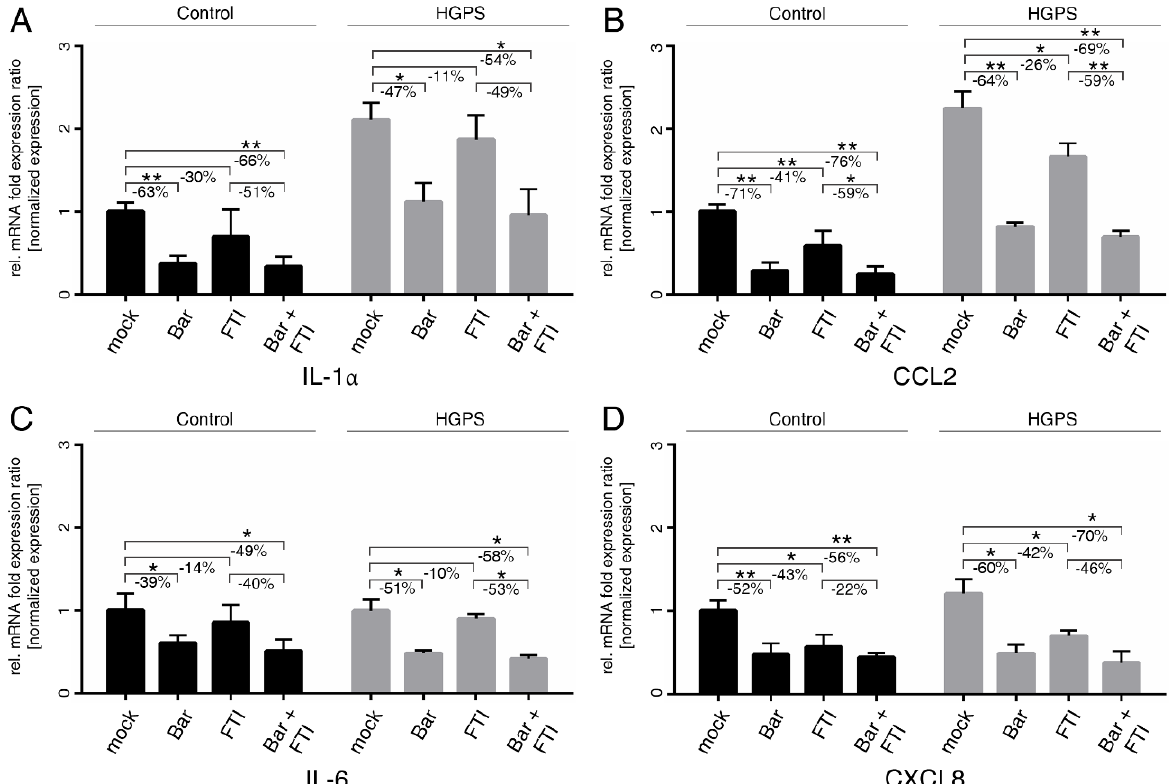
Figure 3. SASP factors are blunted by treatment with Bar and FTI. ( A – D ) Quantitative real-time PCR analysis of IL-1 α , CCL2, IL-6, and CXCL8. Cultures at 15%SNS were either treated with vehicle (DMSO), Bar (1 µM), FTI (0.025 µM), or combined drugs for a period of nine days. Relative expression was normalized to expression of GAPDH. Graphs show mean ± SD ( n = 3; * p < 0.05, ** p < 0.01)